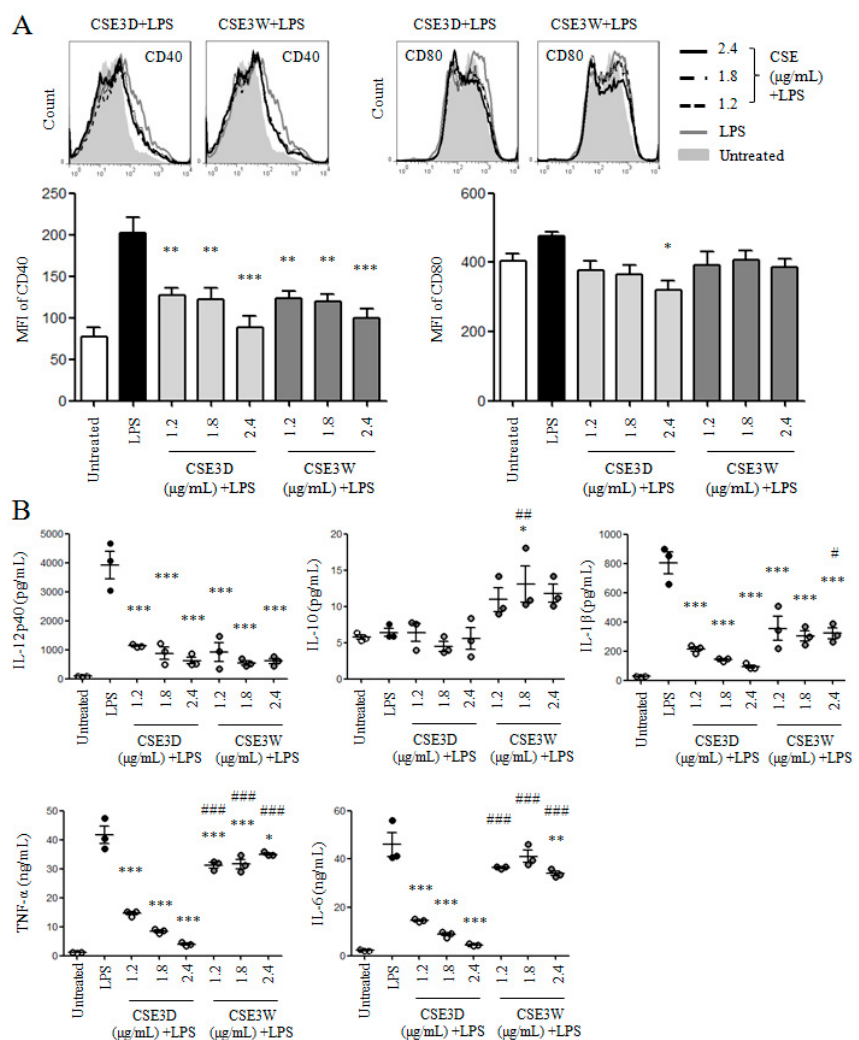
Figure 5. CSE3D and CSE3W suppressed DC maturation and cytokine production induced by LPS. DCs were treated with different concentrations of flavonoids in CSE3D and CSE3W in the presence of LPS for 12 h. ( A ) Cells were collected to analyze the expressions of CD40 and CD80 by flow cytometry. MFI of CD40 and CD80 is shown; ( B ) The supernatants were collected to detect the levels of IL-12p40, IL-10, IL-6, IL-1 β , and TNF- α by ELISA. The concentrations of these cytokines are shown. Data are from three independent experiments and analyzed by ANOVA. * p < 0.05; ** p < 0.01; *** p < 0.001 compared to LPS treated DCs. # p < 0.05; ## p < 0.01; ### p < 0.001 compared to CSE3D + LPS treated DCs. The levels of anti-inflammatory IL-10 and pro-inflammatory cytokines including IL-12p40, IL-6, IL-1 β , and TNF- α in supernatants of the above samples were determined by ELISA. We found that